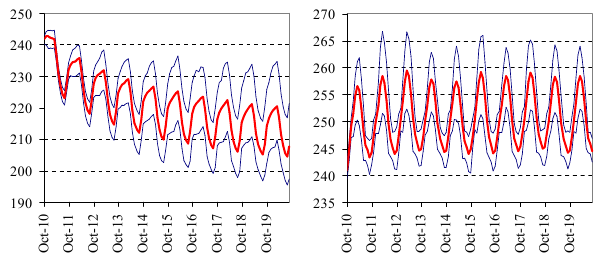
Fig. 11. Simulated level (m) at the upstream part of the aquifer Figure 11 (mean and 50% prediction limits) under the actual abstraction pol- icy (zero pumping for the water supply of Athens), according to modelling frameworks A (left) and B